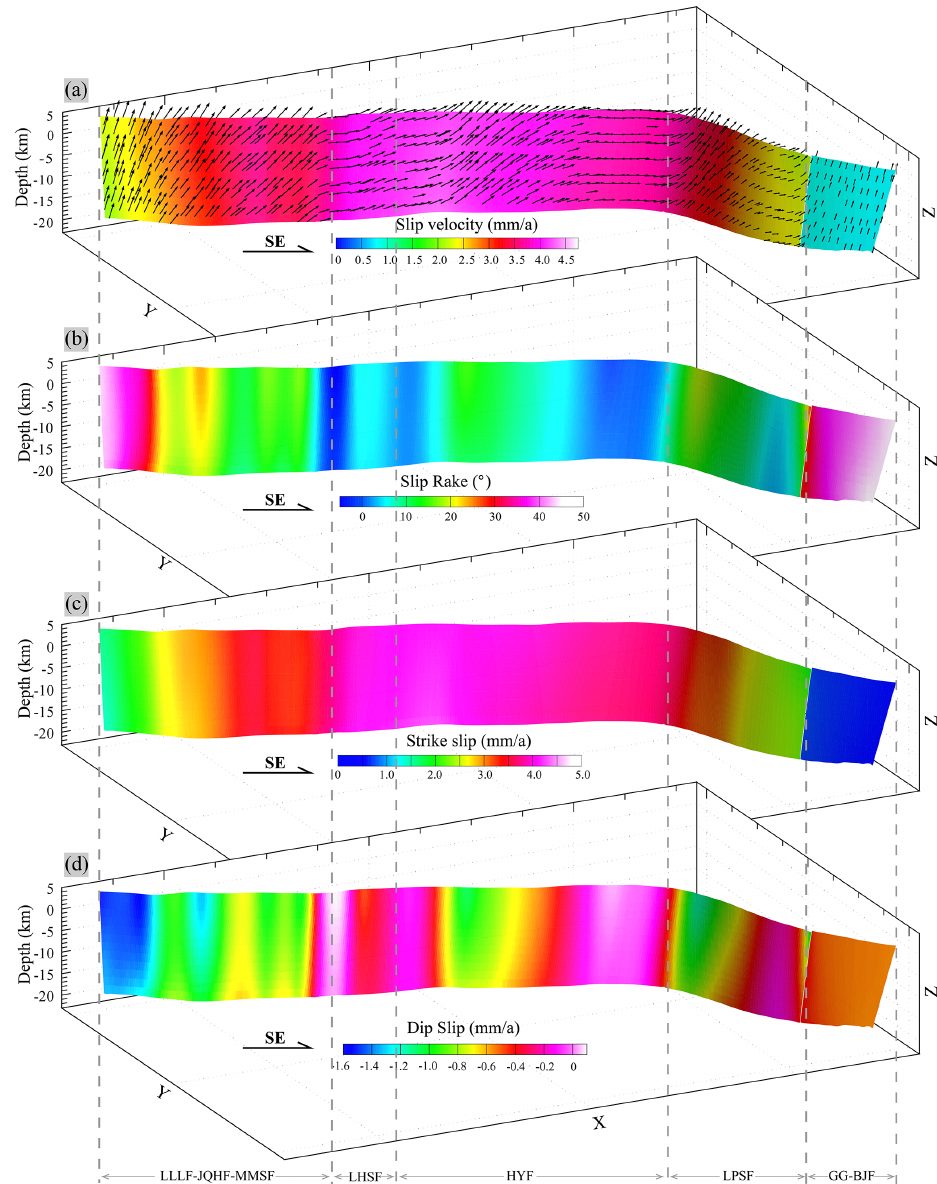
Figure 6. Distribution of the modeled fault slip rates on fault F1. View from SW to NE. The ratio of the vertical to horizontal scale is 4 : 1. (a) Total slip rates with slip directions (black arrows), where parts of the fault have an oblique-slip component. (b) Slip rake, where positive values indicate that the fault movement has a thrust component. (c) Slip rates along strike, where positive values represent sinistral strike-slip. (d) Slip rates along the dip direction, where negative values represent thrust